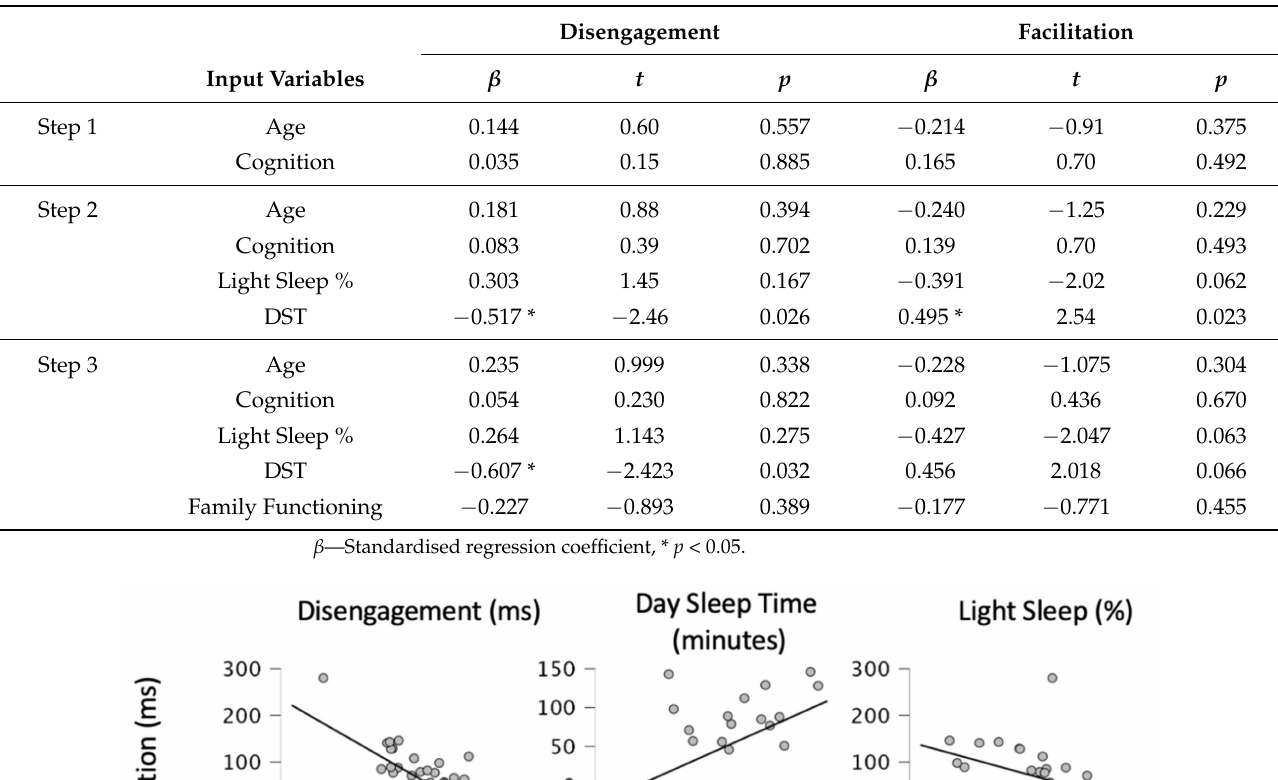
Table 5. Hierarchical regression with Disengagement and Facilitation as outcome variables.